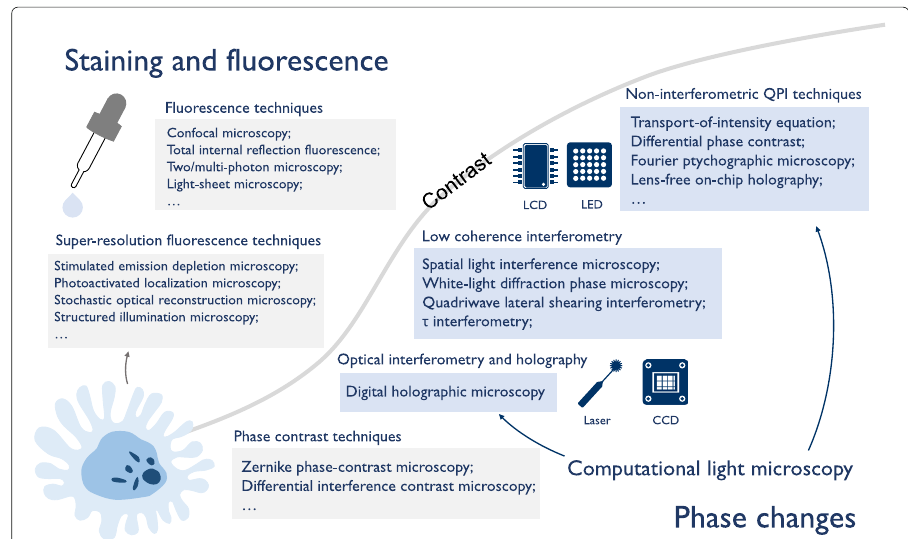
Fig. 1 The motivation and development trend of light microscopy for enhancing “contrast” – from qualitative to quantitative, from interferometric to